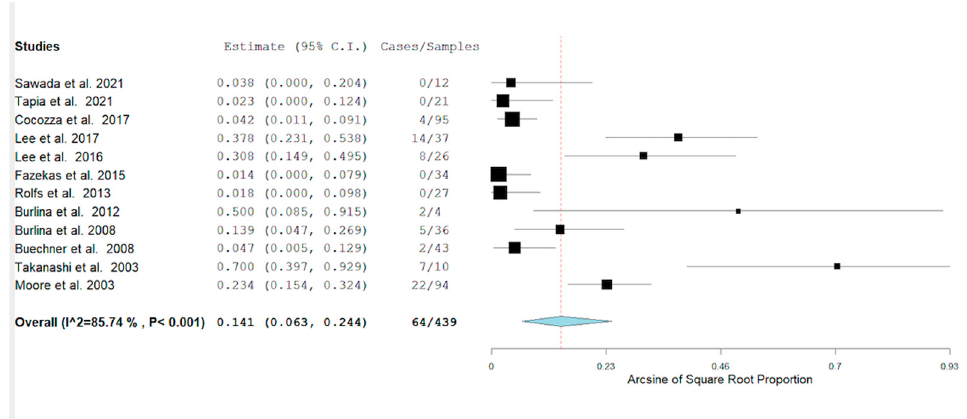
Figure 2. The pool prevalence of the 12 collected studies was 64/439, with a pool prevalence of 0.141 p ≤ 0.001. 95% CI (0.063–0.244).